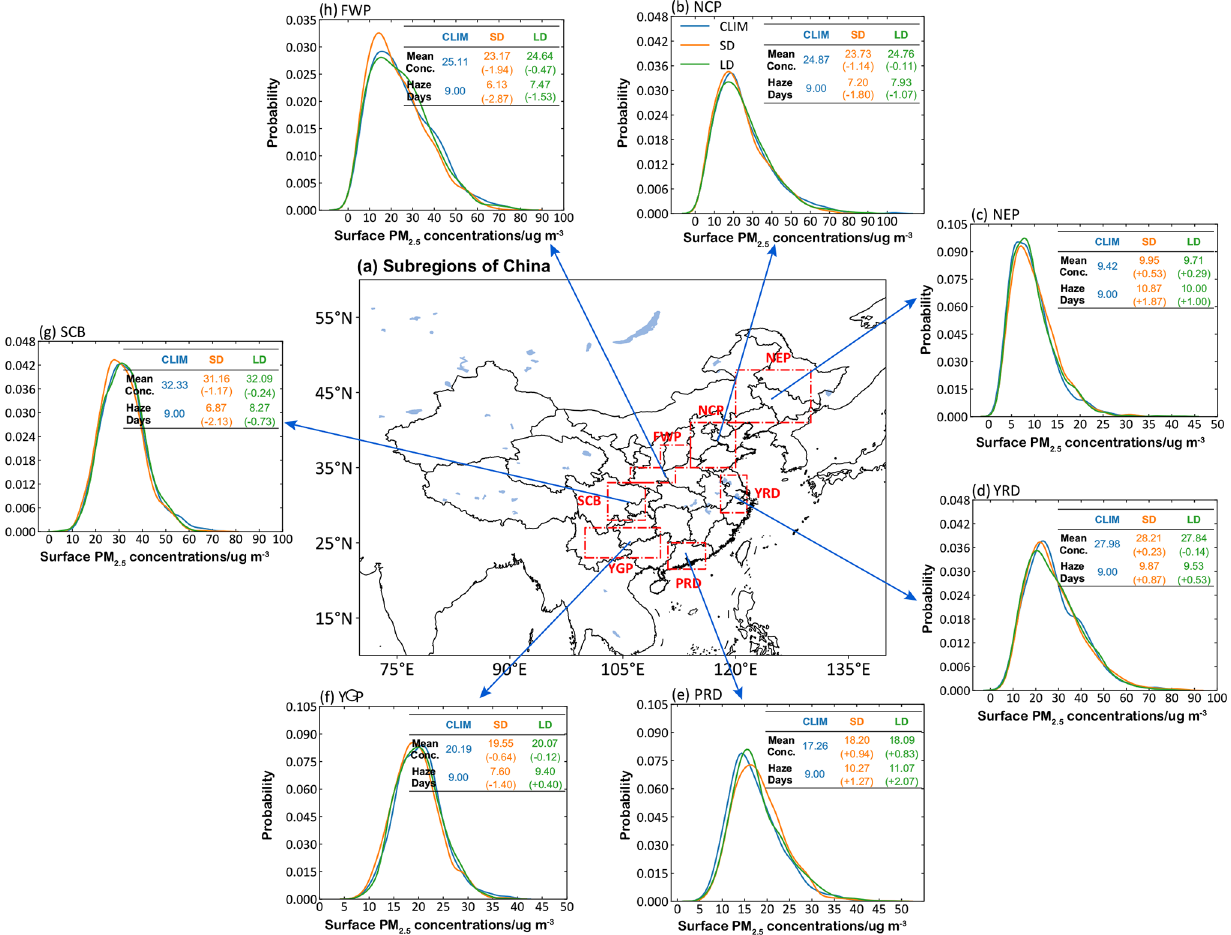
Figure 10. (a) Subregions of China defined in this study, including the North China Plain (NCP, 35–41 ◦ N, 114–120 ◦ E), the Sichuan Basin (SCB, 28–33 ◦ N, 103–108 ◦ E), the Yangtze River Delta (YRD, 29–34 ◦ N, 118–121.5 ◦ E), the Pearl River Delta (PRD, 21.5–25 ◦ N, 111– 116 ◦ E), the Northeast Plain (NEP, 41–48 ◦ N, 120–130 ◦ E), the Yunnan–Guizhou Plateau (YGP, 23–27 ◦ N, 100–110 ◦ E) and the Fenwei Plain (FWP, 33–35 ◦ N, 106–112 ◦ E and 35–38 ◦ N, 110–114 ◦ E). (b – h) Probability density distributions of daily near-surface PM 2 . 5 concentrations (µgm − 3 ) in DJF over various subregions of China. The seasonal mean aerosol concentrations (unit: µgm − 3 ) and number of haze days in December–January–February (DJF) over various regions of China from CLIM, SD and LD experiments are shown in the corresponding table. Haze days are defined as days with daily average near-surface PM 2 . 5 concentrations above the 90th percentile in each region. The values in brackets represent the anomalies in SD and LD relative to